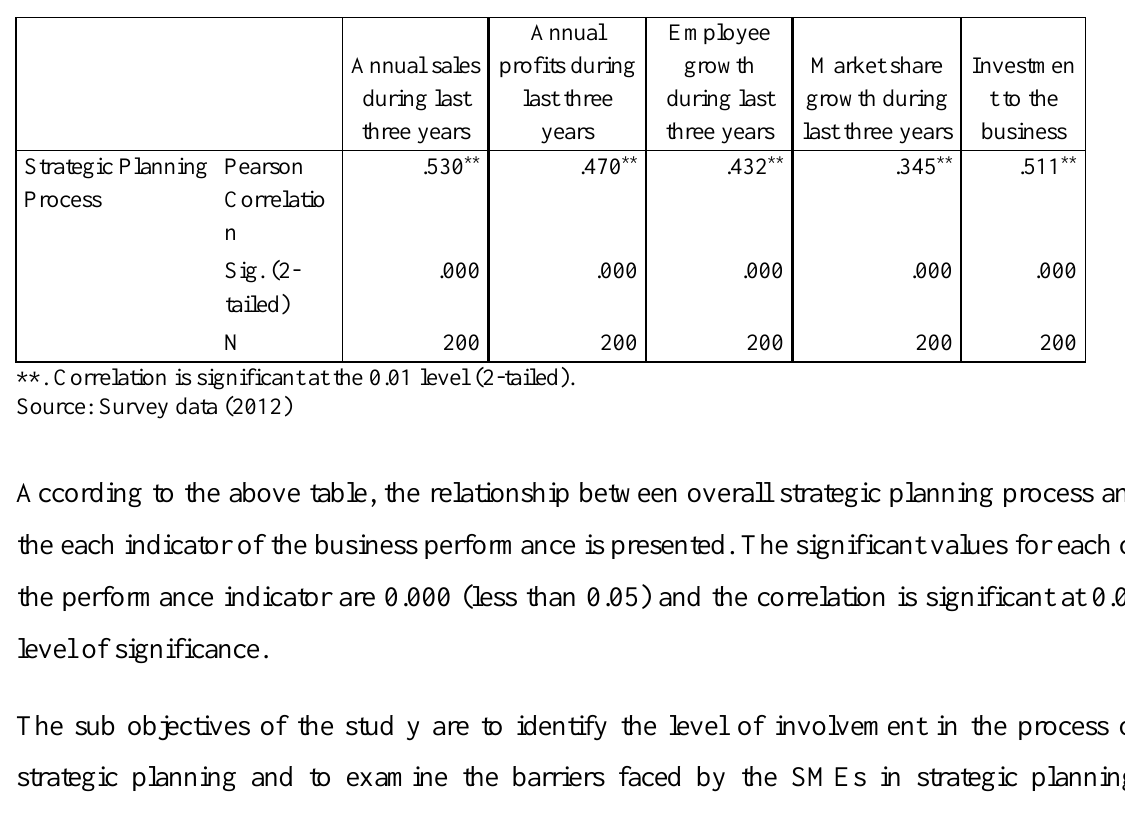
Table 7: Relationship between Overall Strategic Planning Process and the each Variable of Business Performance